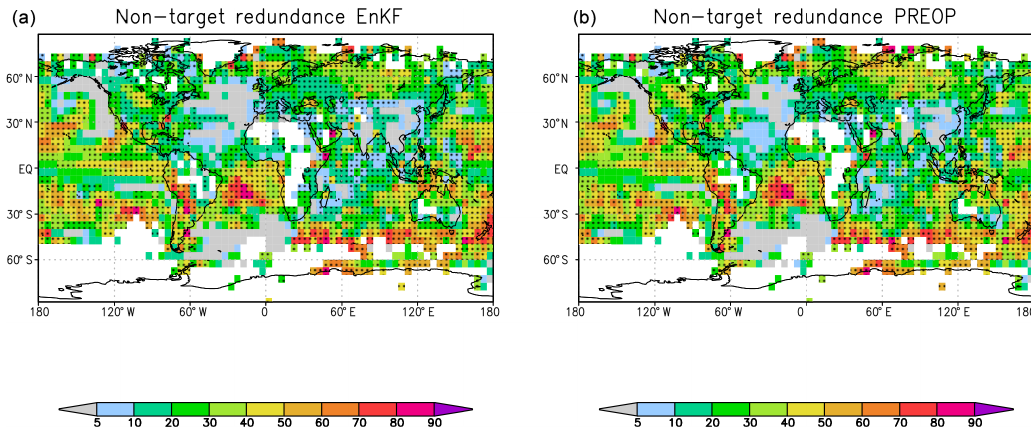
Figure 3. As in Fig. 1 but for non-target redundances in EnKF (a) and in PREOP (b) . Units are a fraction of the explained variance in the respective model in